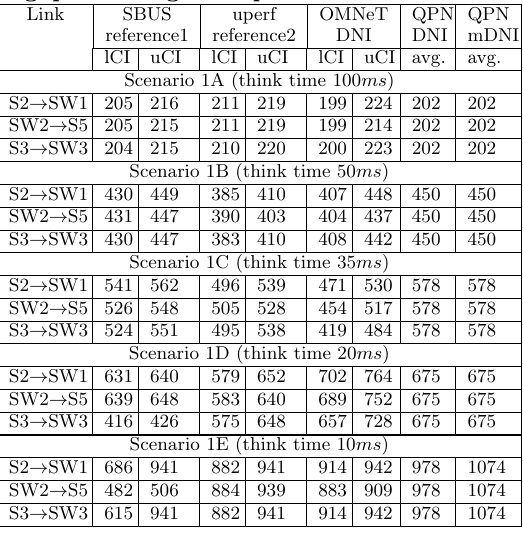
Table 3: Scenario 1A-E: measured and predicted throughput in mega-bits per second Link